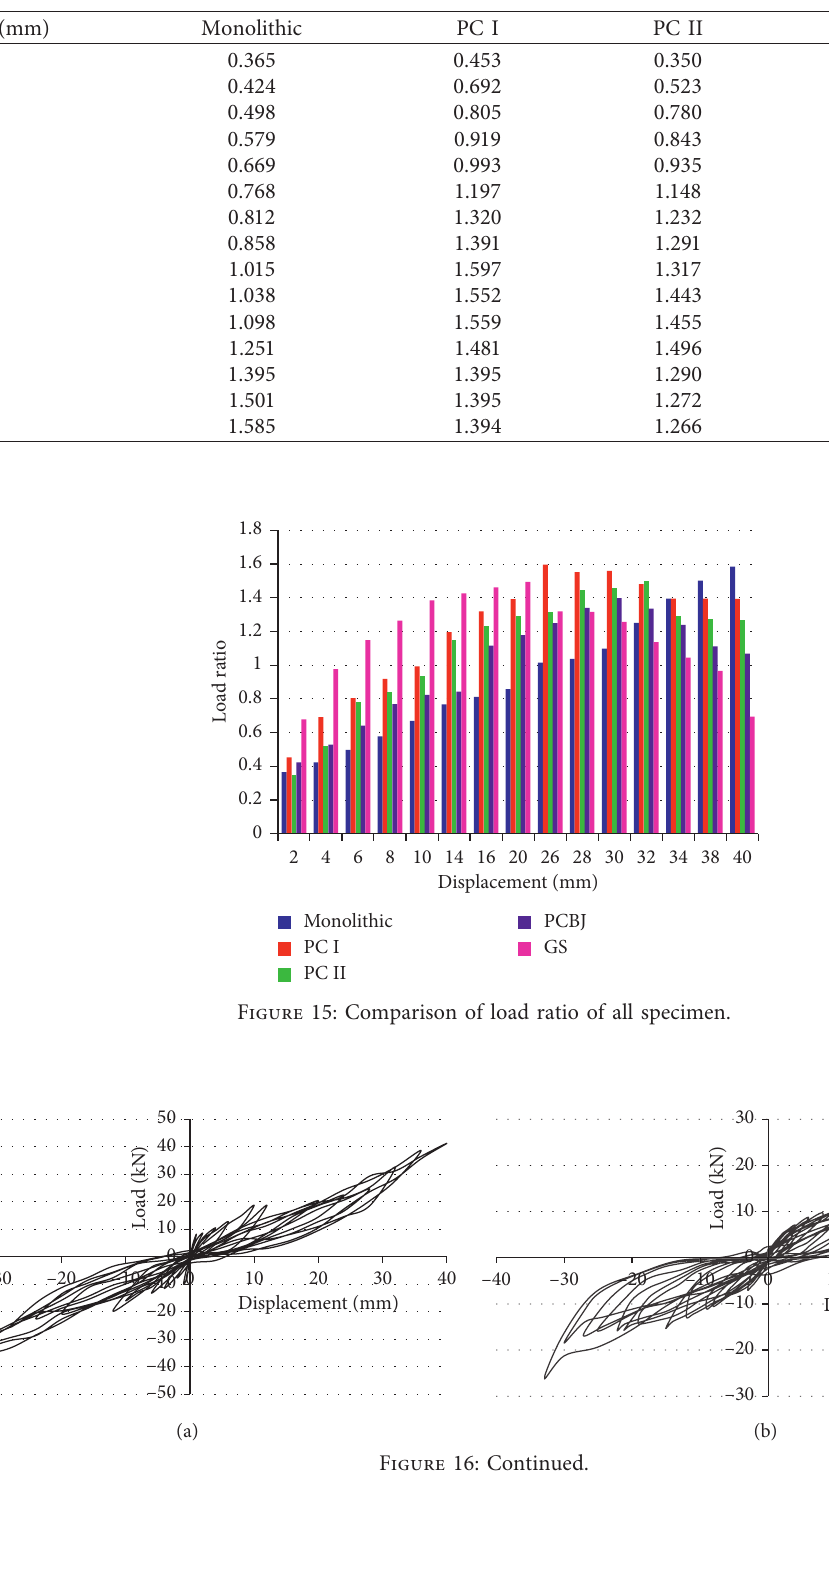
Table 4: Load ratio of all specimens.